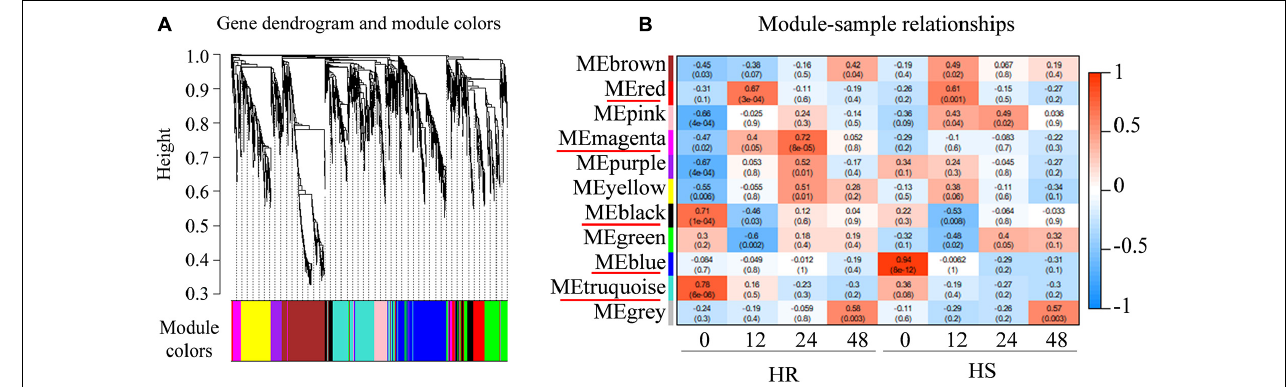
FIGURE 5 | Weighted gene co-expression network analysis (WGCNA) of differentially expressed genes (DEGs) from Shidalukang 1 (HR) and Junmian 1 (HS) at 0, 12, 24, and 48 h post-inoculation. (A) Hierarchical cluster tree of WGCNA analysis. In total, 2,868 DEGs were grouped into 11 co-expression modules labeled with different colors based on the calculation of eigengenes. Each leaf in the tree and each major tree branch represent one gene and a distinct module, respectively. (B) Module–sample correlation. The color at the row–column intersection shows the level of correlation between each module and sample. The modules showing a high degree of correlation ( P < 0.001) with samples are indicated by a red underline.